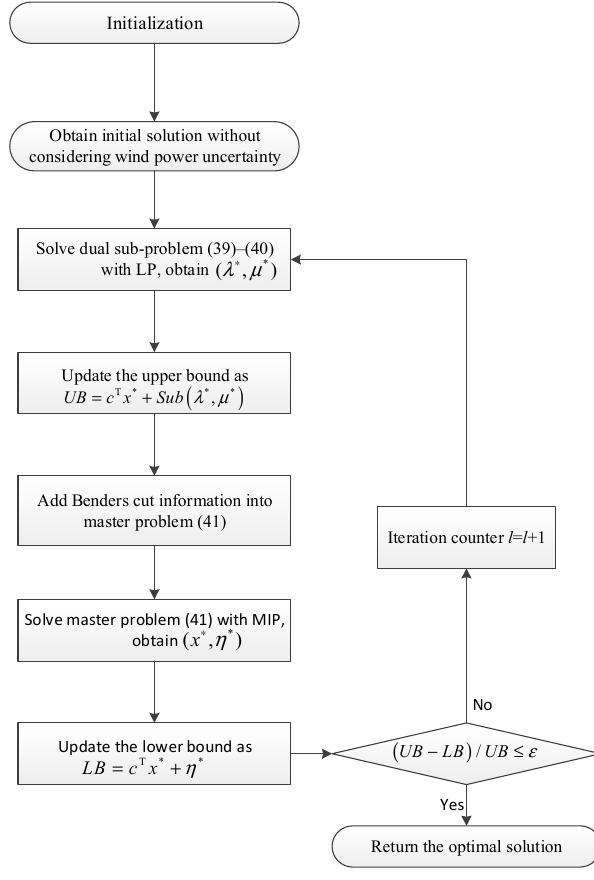
Figure 2. Flow chart of the two-stage robust TEP (RTEP) solution algorithm.